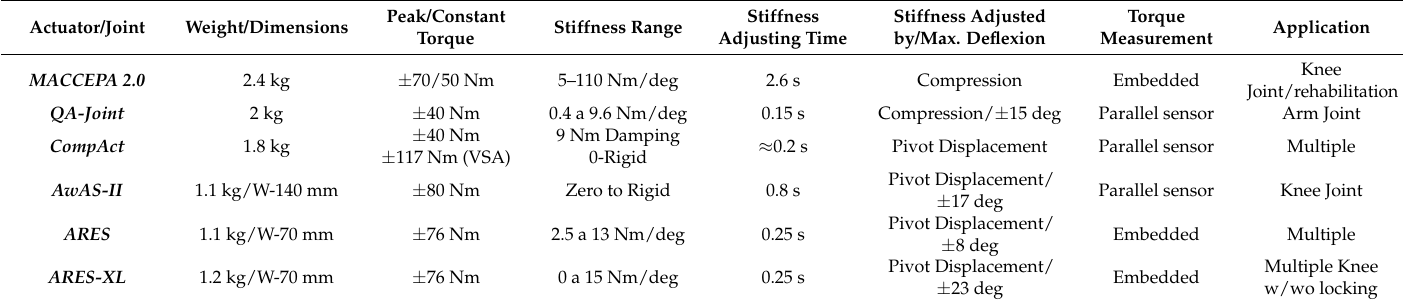
Table 2. State-of-the-art (SoA) actuators comparison and